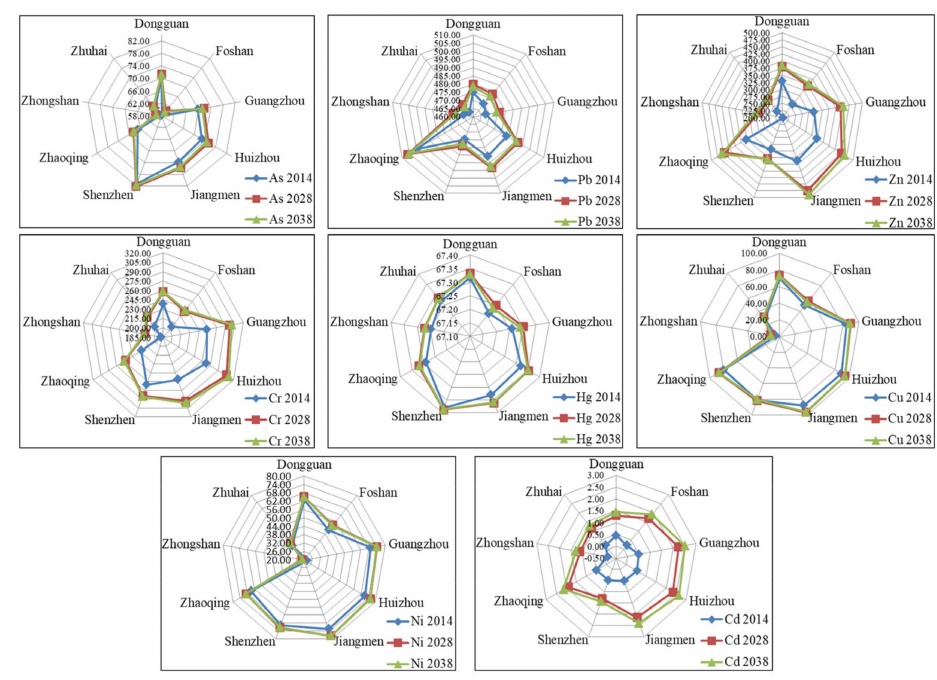
Figure 3. Dynamic environmental capacity in the soil in the Pearl River